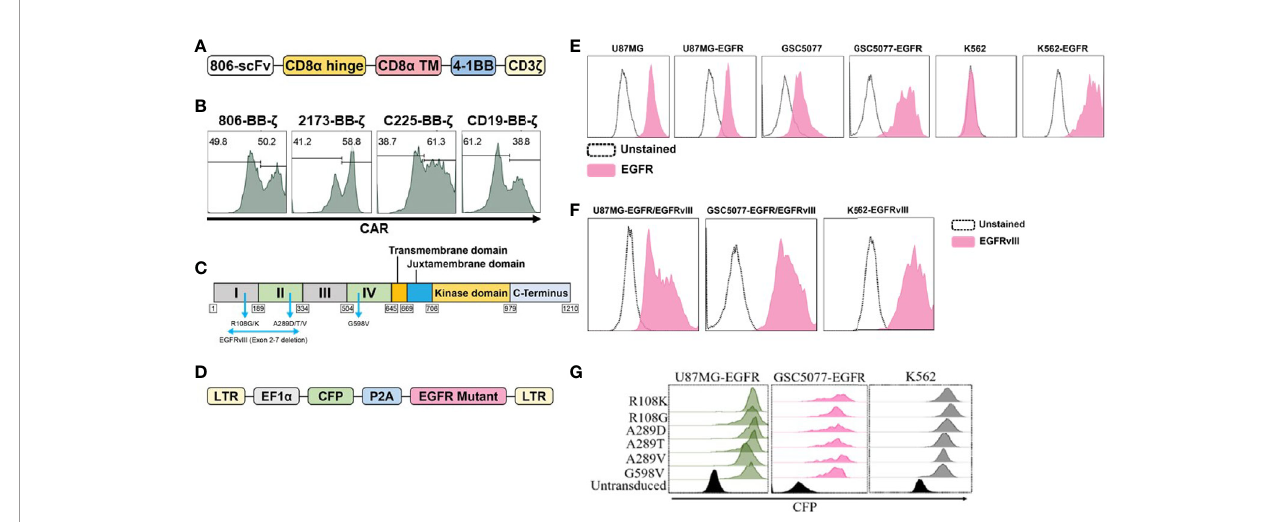
FIGURE 1 | Construction and expression of 806 CAR and EGFR mutant cell lines. (A) Schematic diagram of vector map of 806 CAR containing the 4-1BB co- stimulatory domain. (B) CAR surface expression in primary human CD4 + and CD8 + T cells. Human T cells were simulated for 24 h with anti-CD3/anti-CD28 T-cell activating beads and transduced with CAR transgenes, and CAR expression was analyzed by fl ow cytometry using biotinylated goat-anti-mouse (806, C225, and CD19 CARs) and goat-anti human F(ab)2 fragment-speci fi c antibodies (2173 CARs) followed by secondary staining with streptavidin-APC. (C) Schematic showing targeted missense mutations in the extracellular domain of EGFR, EGFR R108K/G , EGFR A289D/T/V , EGFR G598V , and splice variant EGFRvIII. (D) Schematic of lentiviral vector co-expressing CFP and wtEGFR or EGFR mutant. (E) Flow-based analysis of endogenous and ectopically expressed EGFR in U87MG, GSC5077, and K562 cell lines using the cetuximab antibody. (F) U87MG, U87MG-EGFR, and GSC5077-EGFR expression of EGFRvIII. (G) U87MG-EGFR, GSC5077-EGFR, and K562 cell lines were transduced with a lentiviral vector co-expressing CFP and indicated EGFR missense mutations and sorted by CFP expression using fl uorescent- activated cell